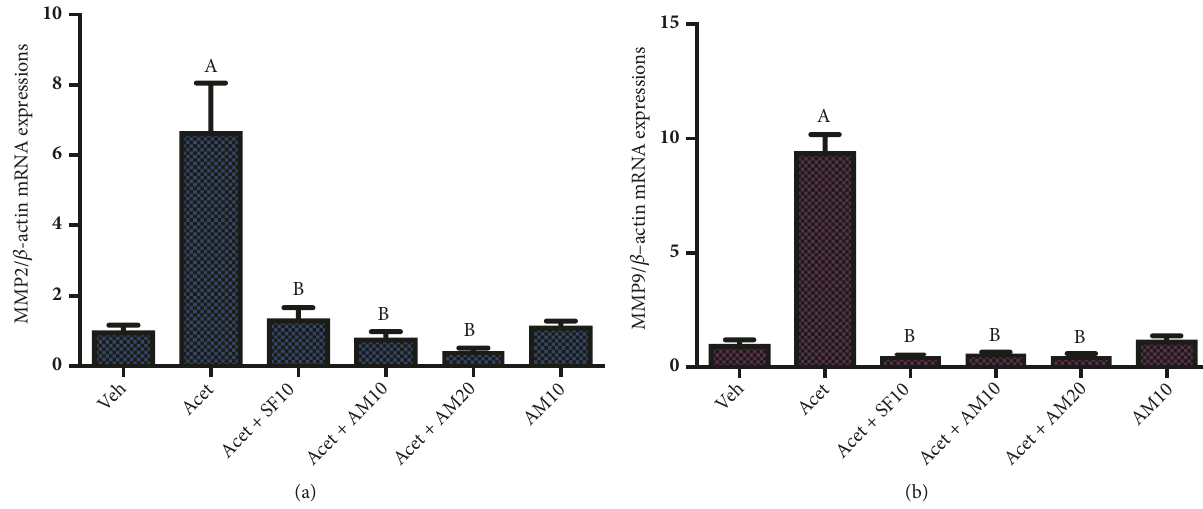
Figure 6: Effect of alpha mangostin on HSCs migration markers as shown by mRNA expressions of (a) MMP2/ 𝛽 -actin and (b) MMP9/ 𝛽 - actin, after LX-2 cells were treated with alpha mangostin with or without acetaldehyde induction. Results were presented as mean ± SEM. A: p < 0.05 versus untreated group, B: p < 0.05 versus acetaldehyde group. Veh: vehicle only, Acet: acetaldehyde 100 𝜇 M, Acet + SF10: acetaldehyde 100 𝜇 M + sorafenib 10 𝜇 M, Acet + AM10: acetaldehyde 100 𝜇 M + alpha mangostin 10 𝜇 M, Acet + AM20: acetaldehyde 100 𝜇 M + alpha mangostin 20 𝜇 M, AM 10: alpha mangostin 10 𝜇